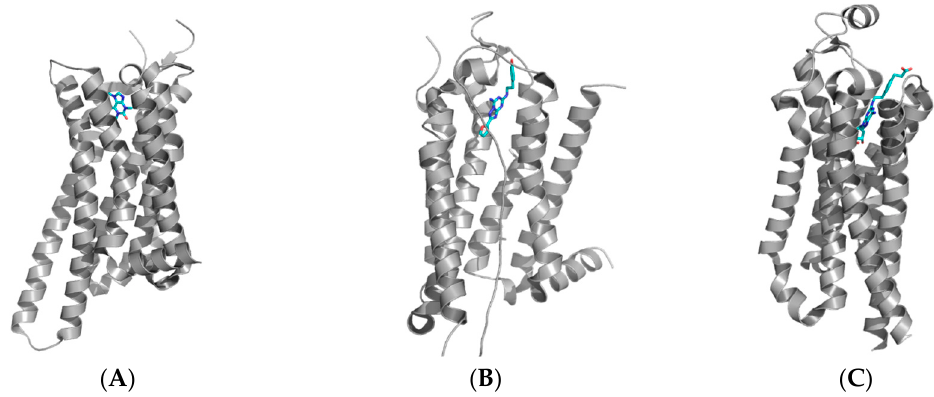
Figure 2. Structures of the adenosine A 2A receptor with ( A ) caffeine (PDB: 3RFM); ( B ) the antagonist ZM241385 (PDB: 3EML); and ( C ) the agonist CGS21680 (PDB: 4UG2). It has been shown that the extracellular loops play an important role in the agonist/antagonist interaction of compounds with the receptors. These crystal structures have been used to design novel small organic compounds which can be used to target the adenosine receptors.